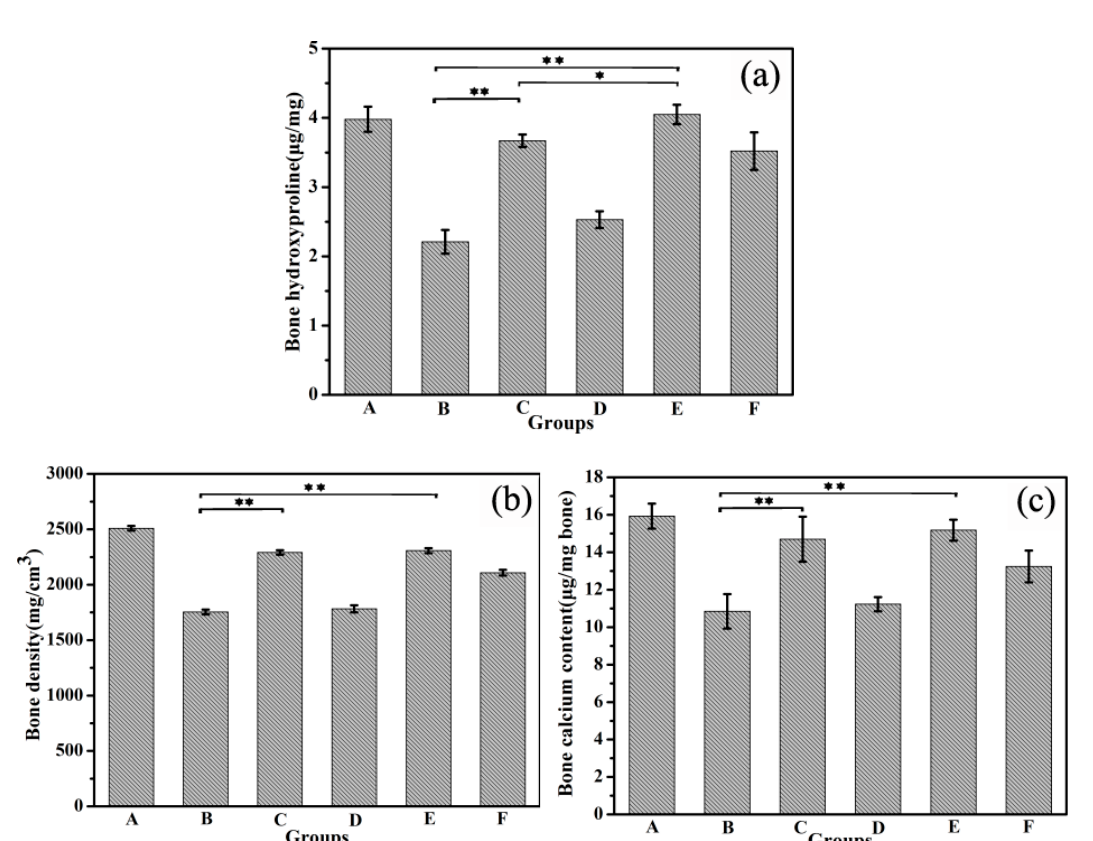
Figure 11. Bone hydroxyproline content ( a ) Bone density ( b ) and Bone calcium content of osteoporosis mice that supplement calcium for 12 weeks ( c ). A, Control group; B, Ca-deficiency group; C, PHLC-Ca group; D, Empty CS/ALG group; E, CS/ALG-(PHLC-Ca) group; F, Col-Ca group. * p < 0.05; ** p <